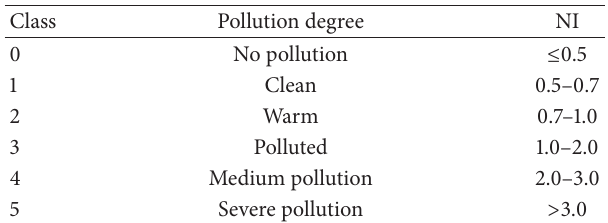
Table 1: Classification of